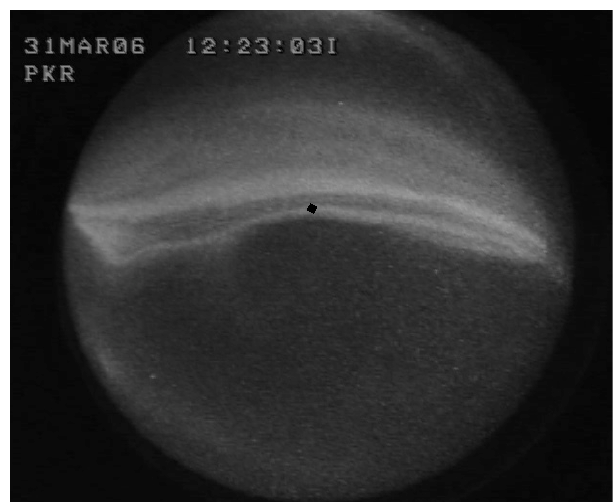
Fig. 7. An all-sky camera image showing the auroral arc location relative to the field-aligned radar beam location at 100km altitude. North is on the bottom and east is to the right. This image corre- sponds to the time of NEIAL